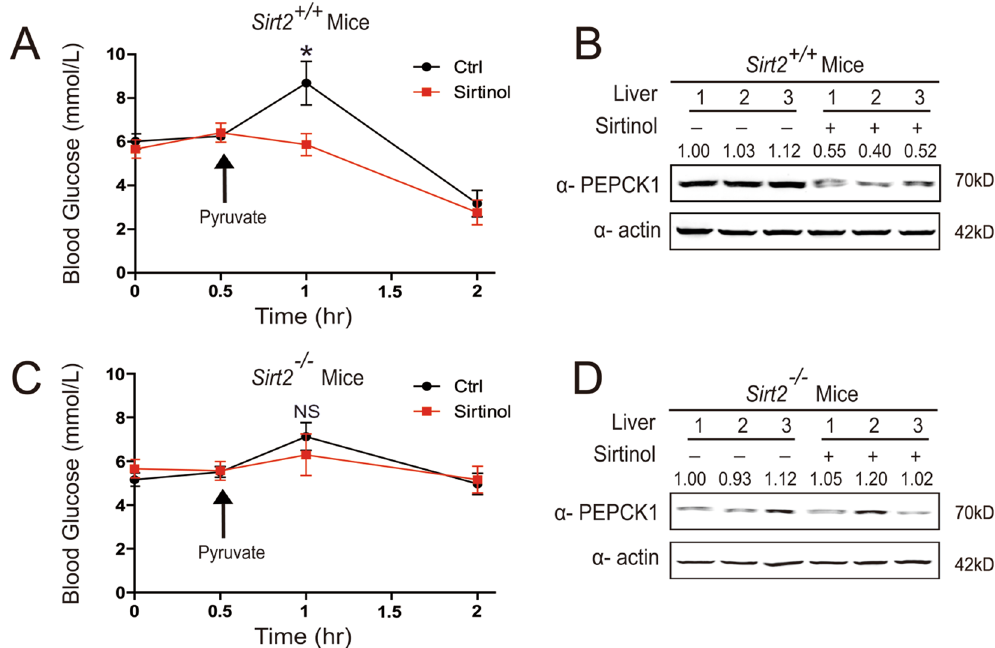
Figure 6. Sirtinol destabilizes PEPCK1 and inhibits gluconeogenesis in mice. ( A ) sirt2 + / + mice (n = 6) were starved overnight, then blood glucose were measured at different time points as indicated. Two groups of mice were injected with saline and sirtinol (10 mg/kg body weight) respectively at the begining. Then pyruvate (2 g/ kg body weight) were injected as indicated. ( B ) sirt2 + / + mice were sacrificed after pyruvate tolerance tests, liver tissue were harvested and lysated, then visualized by Western blotting. ( C ) sirt2 − / − mice (n = 6) were starved for overnight, then blood glucose were measured at different time points as indicated. Two groups of mice were injected with saline and sirtinol (10 mg/kg body weight) respectively at the begining. Then pyruvate (2 g/ kg body weight) were injected as indicated. ( D ) sirt2 − / − mice were sacrificed after pyruvate tolerance tests, liver tissue were harvested and lysated, then visualized by Western blotting. The data are represented as the means ± SEM. * P < 0.05; ** P < 0.01; NS, not